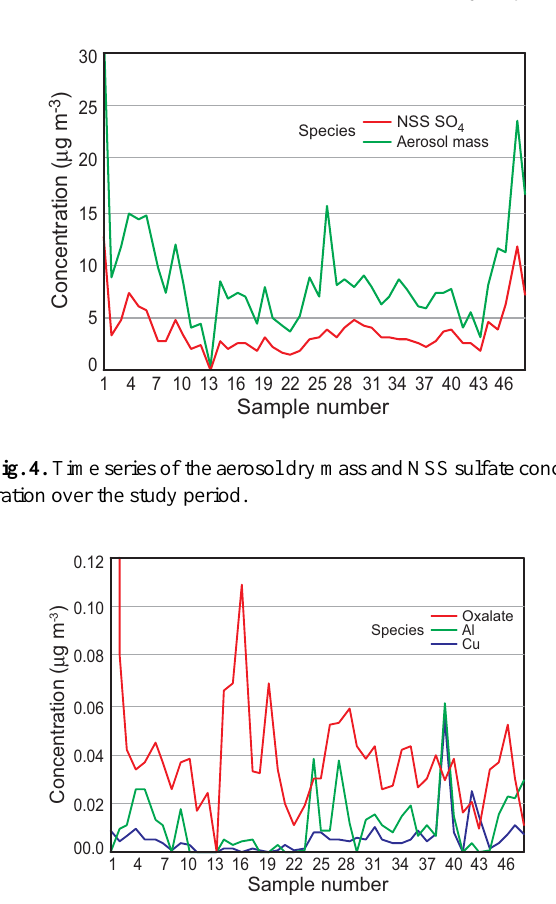
3 Figure 5 : Time series of oxalate (red), aluminum (green) and copper (blue) over the study 4 Fig. 5. Time series of oxalate (red), aluminum (green) and copper period. 5 6 (blue) over the study period. The date and time of filter sampling is shown in Table 1.